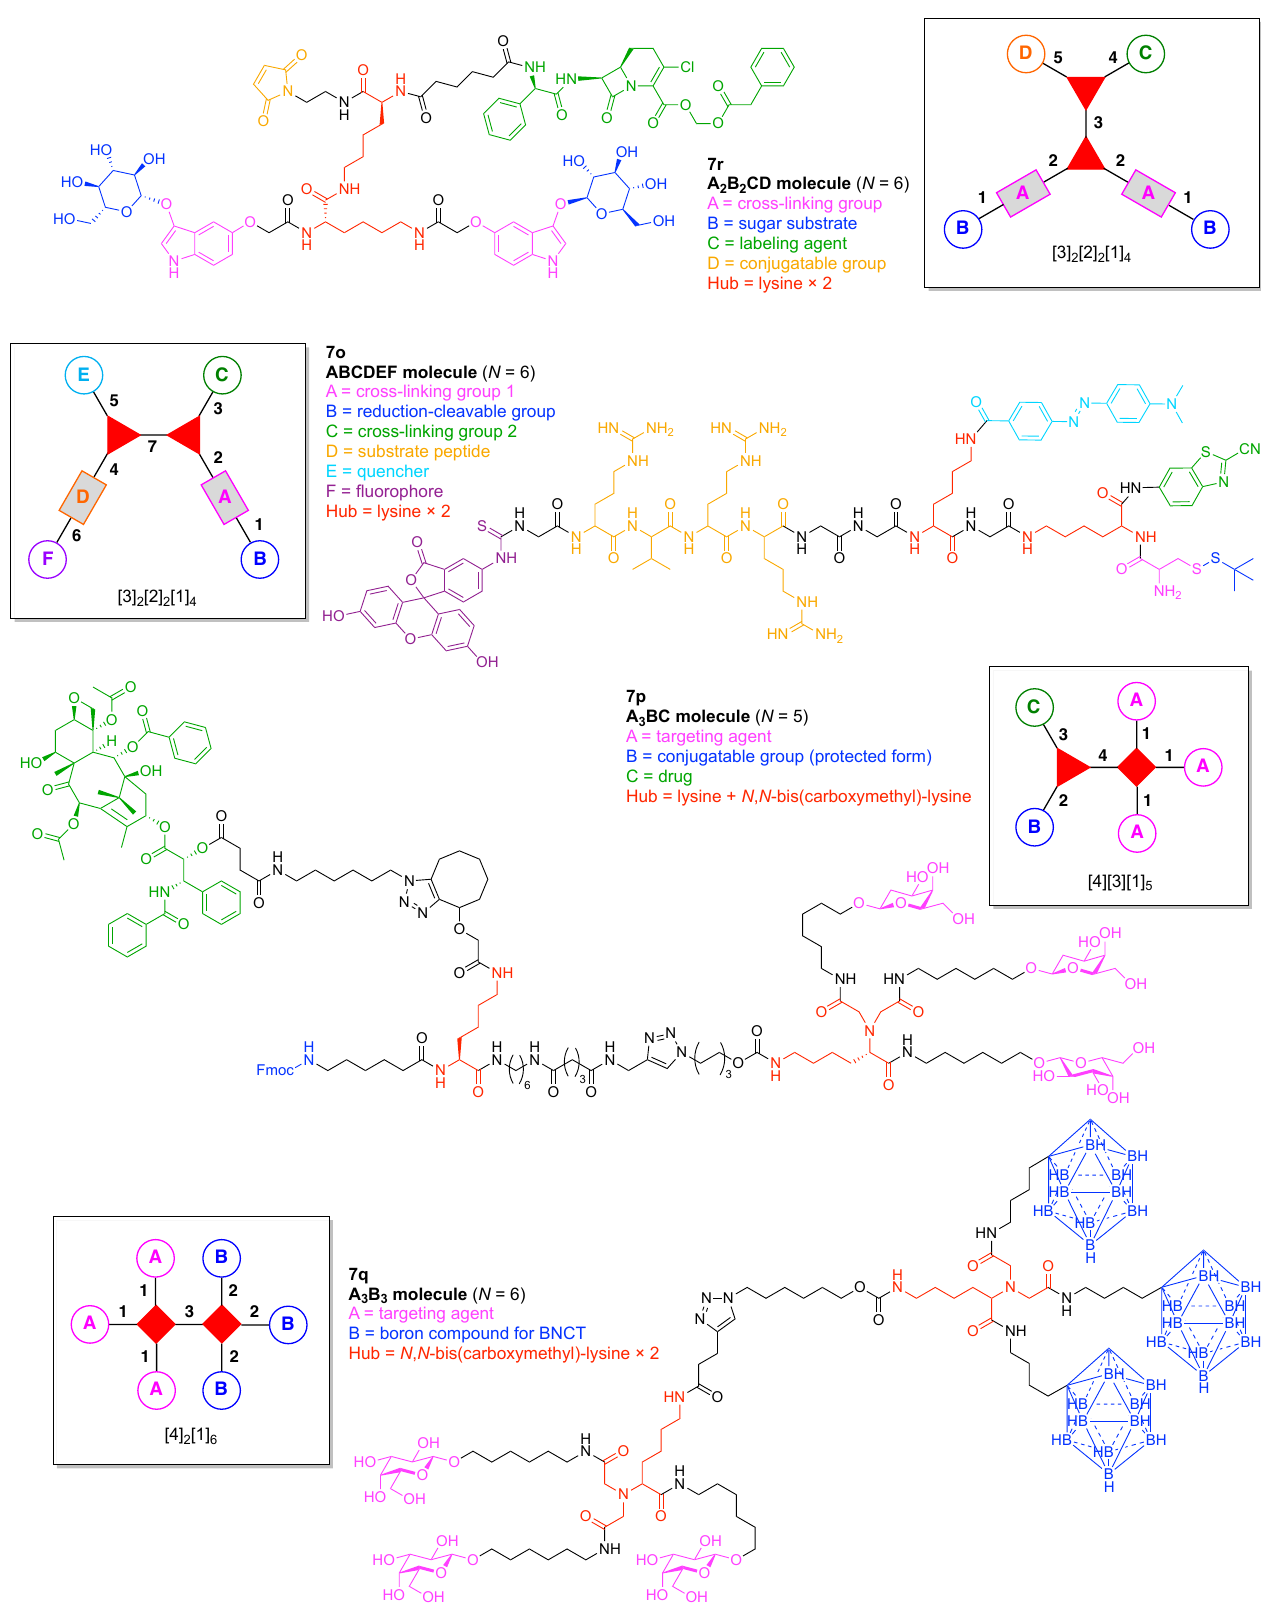
Figure 17. Four examples each with two lysine or lysine-based hubs. A paclitaxel/galactose-functionalized compound ( 7p ) was developed to create fluo- rescent nanoparticles (NPs) for real-time imaging and cancer-cell targeting (Figure 17)